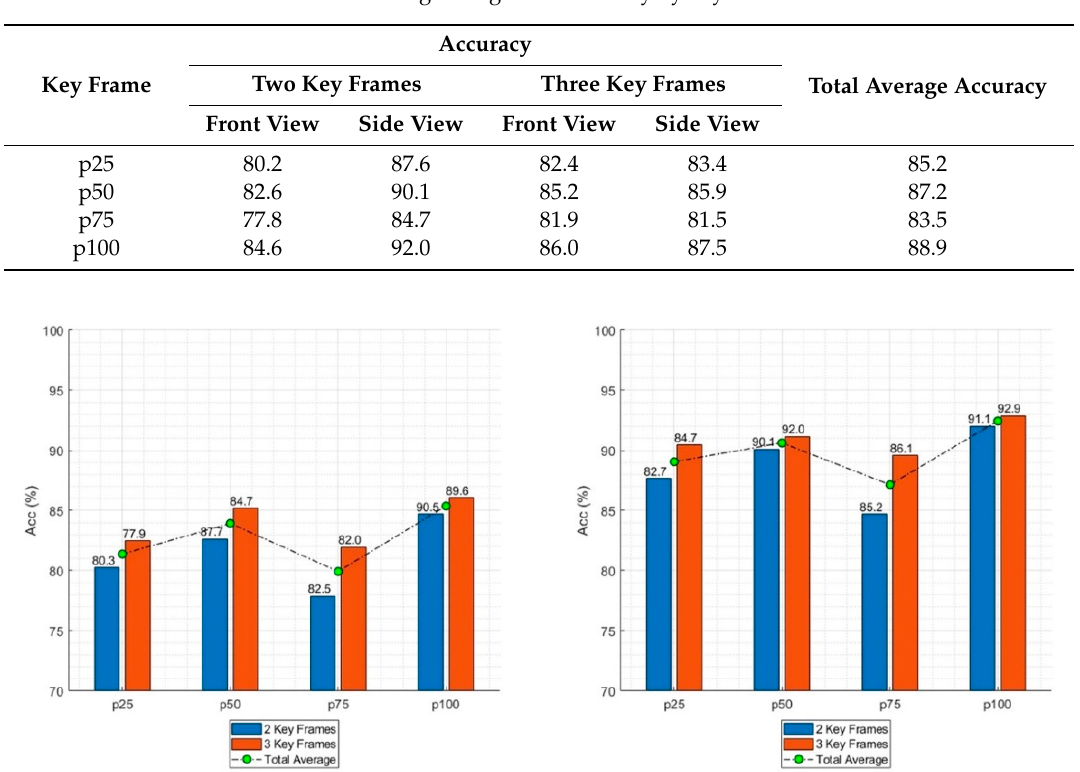
Table 6. Average recognition accuracy by key frames.